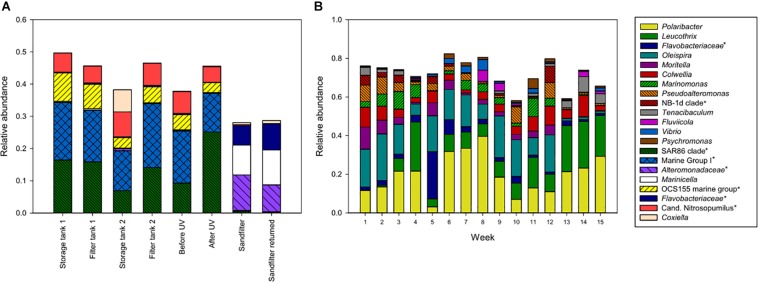
Amplicon libraries of intake water (A) and water from fish tanks (B). Intake water included storage tanks, drum filter tanks, and water before and after UV treatment, in addition to the sand filter connected to the hatchery. For fish tanks, the bars show the average community compositions from 8 parallel weaning tanks sampled in week 1–4, and 4 parallel grow-out tanks sampled in week 5–15. Taxa with >5% relative abundance in at least one sample are shown. This includes unnamed genera in the Silva database, indicated with an asterisk and named at a higher taxonomic rank.